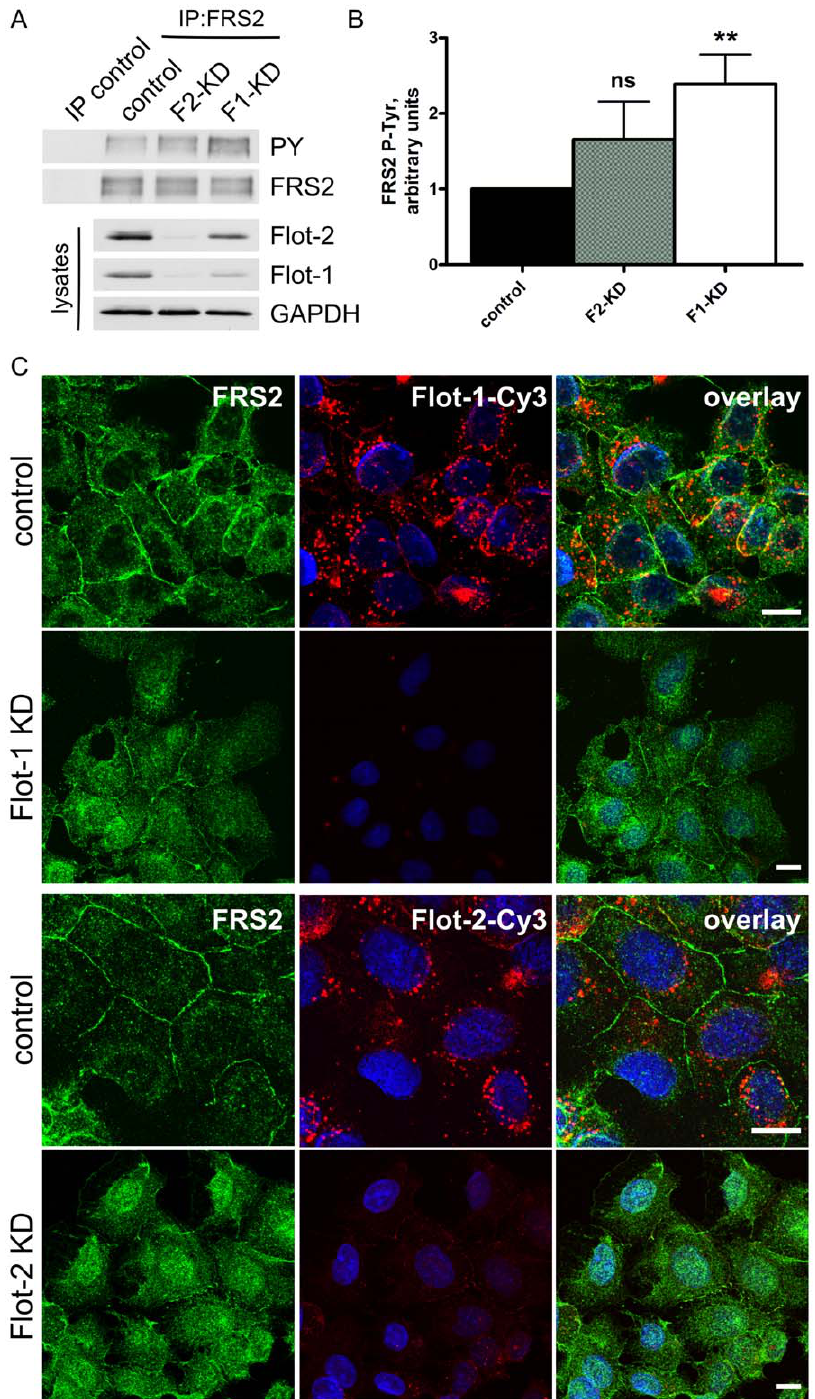
Figure 4. Increased Tyr phosphorylation and solubility of FRS2 in flotillin knockdown cells. (A) FRS2 was immunoprecipitated from serum grown Hep3B cells. The Tyr phosphorylation of FRS2 was measured by means of phospho-Tyr antibodies and found to be increased both in flot-1 and flot-2 knockdown cells. (B) Densitometric quantification of FRS2 phosphorylation with SD (5 independent experiments). F1-KD cells display a significantly increased P-Tyr of FRS2. (C) Hep3B cells were grown under serum, fixed and stained with antibodies against FRS2 (left column) and flotillins (middle). In control cells, FRS2 was localized at the plasma membrane and within the cytosol, whereas in flot-1 or flot-2 knockdown cells, a cytosolic staining was evident. In addition, especially in flot-2 knockdown, some nuclear staining was observed. Right column: overlay with DAPI staining. Scale bars 10 m m.